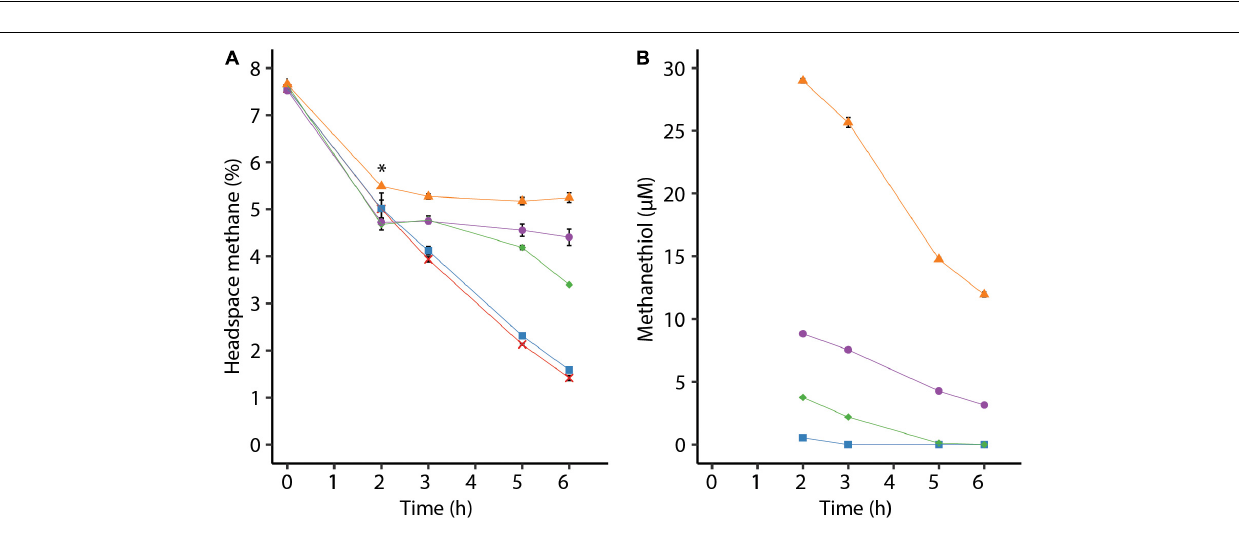
FIGURE 2 | (A) Consumption of methane by Methylacidiphilum fumariolicum SolV cells over time and (B) decrease of methanethiol over time due to microbial and chemical degradation. The asterisk in panel (A) indicates the time point at which different amounts of methanethiol were added, leading to liquid methanethiol concentrations shown in panel (B) . To the positive control (red crosses) no methanethiol was added. Error bars indicate standard deviation ( n =